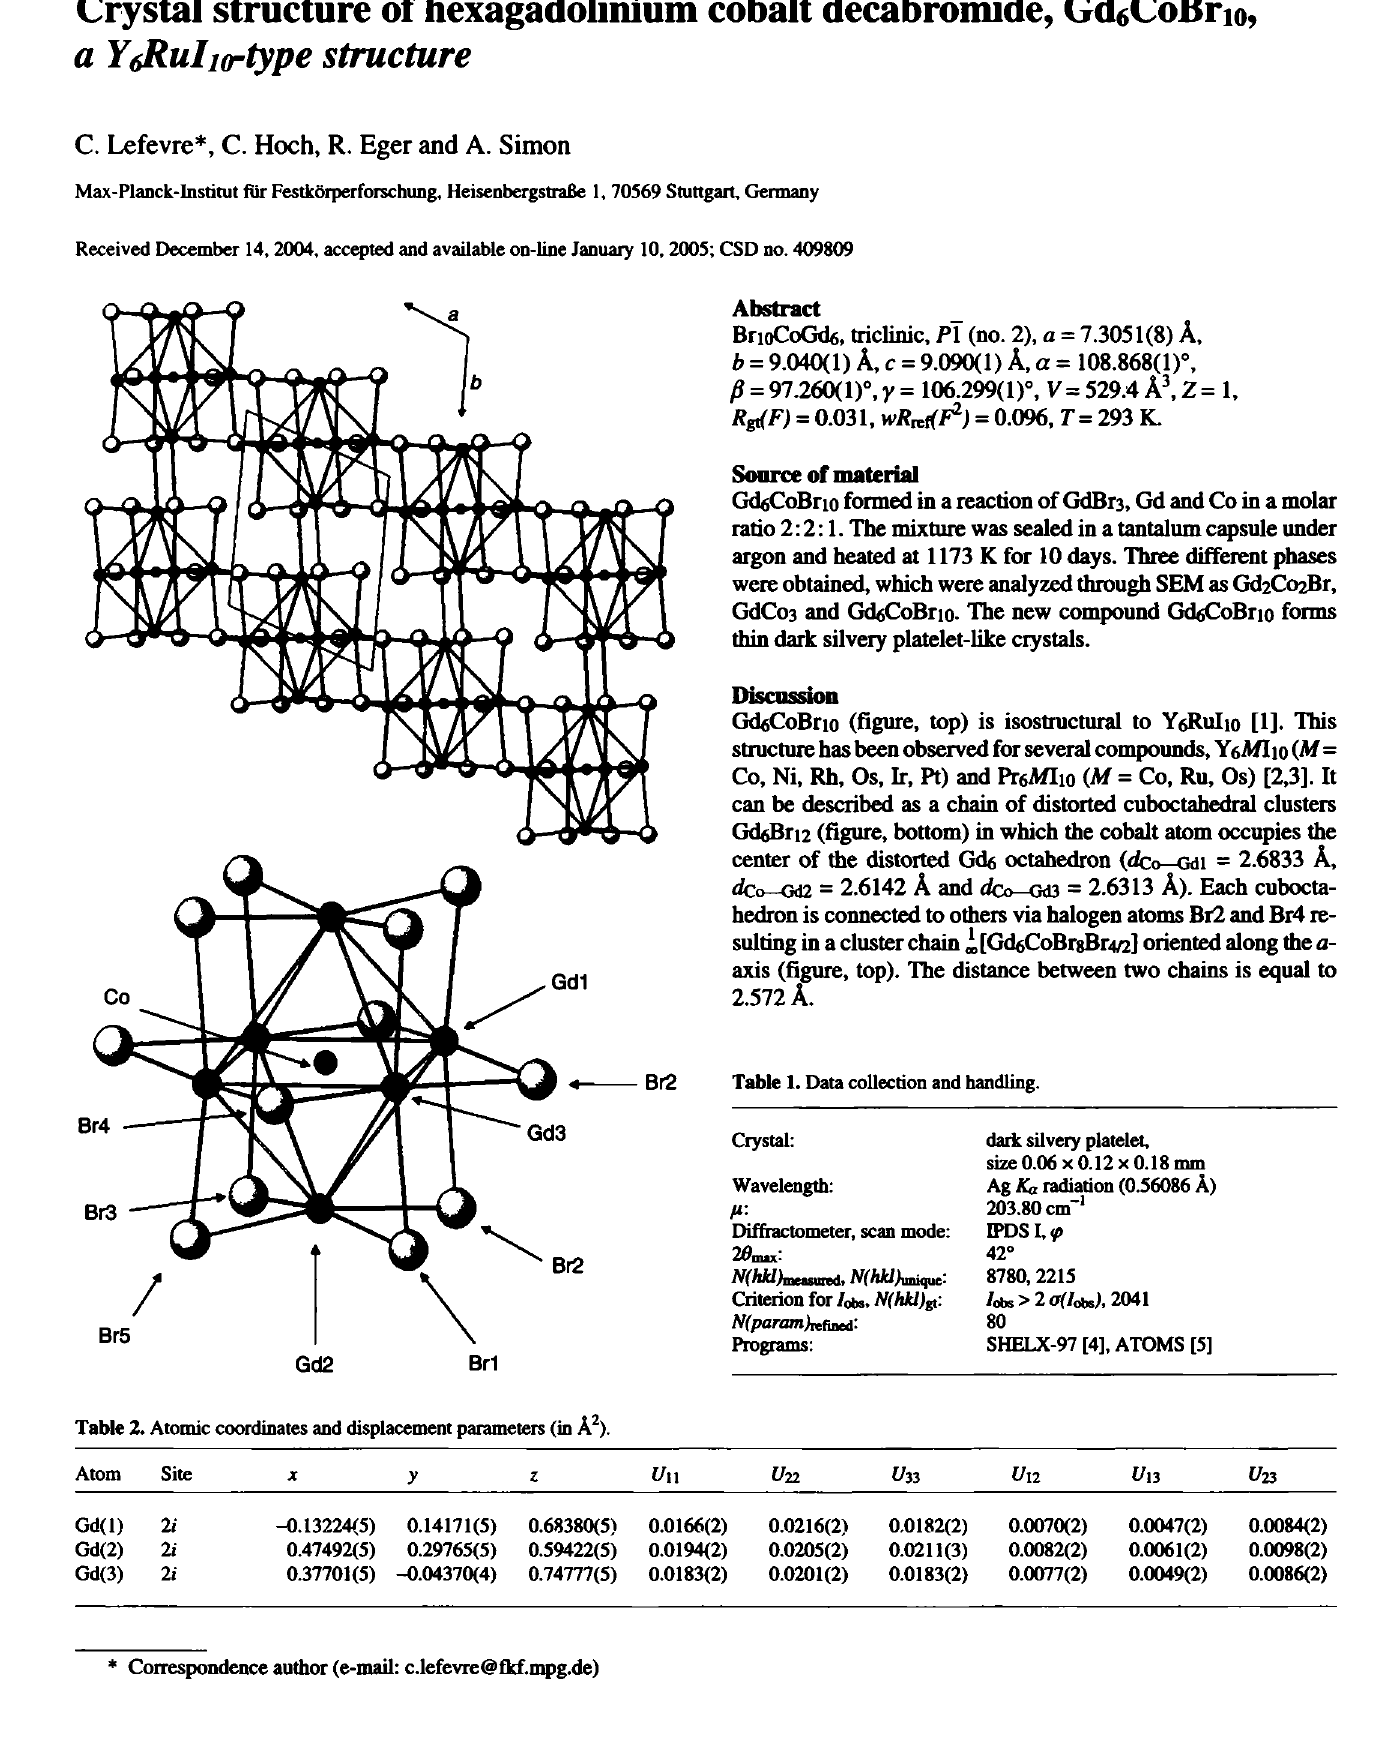
Table 2. Atomic coordinates and displacement parameters (in A 2